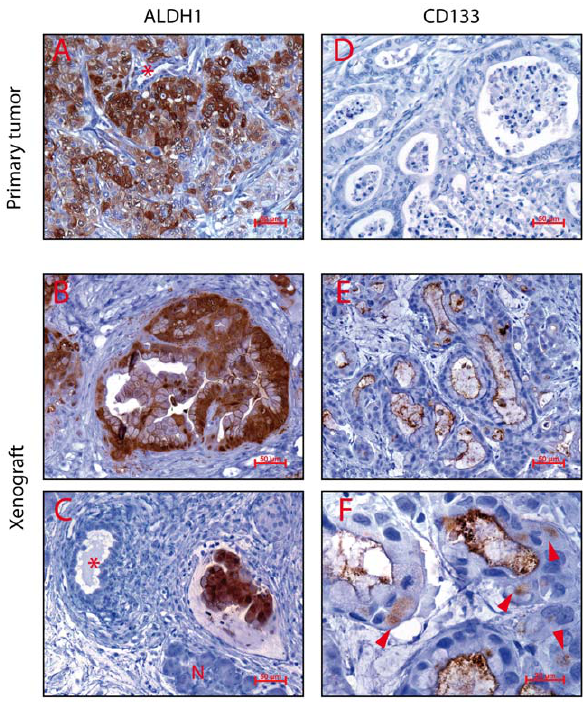
Figure 11. Expression of ALDH1 and CD133 in primary and xenograft tumours. Immunohistochemistry of ALDH1 and CD133 was performed for primary and xenograft tumours. A–C. ALDH1 expression was dispersed in primary (A) and more defined in xenograft tumours (B, C). Cells expressing ALDH1 were typically arranged in ductal structures with focal mucin inclusions (B). Ducts lined with cells not expressing ALDH1 lacked these inclusions (indicated by asterisks in A and C). Panel C shows ALDH1-positive cells invading a lymphatic vessel, while surrounding tumour cells were ALDH1-negative. Normal pancre- atic tissue was present (Picture C, indicated by ’’N’’). E,F. Expression of CD133 was observed only in xenograft tissues. Here, CD133 was expressed predominantly in the lumen of ducts. Ductal epithial cells stained positive at the apical membrane (E) and occasionally intracellularly (F, arrow heads). Detritus within the lumen was typically stained positive.